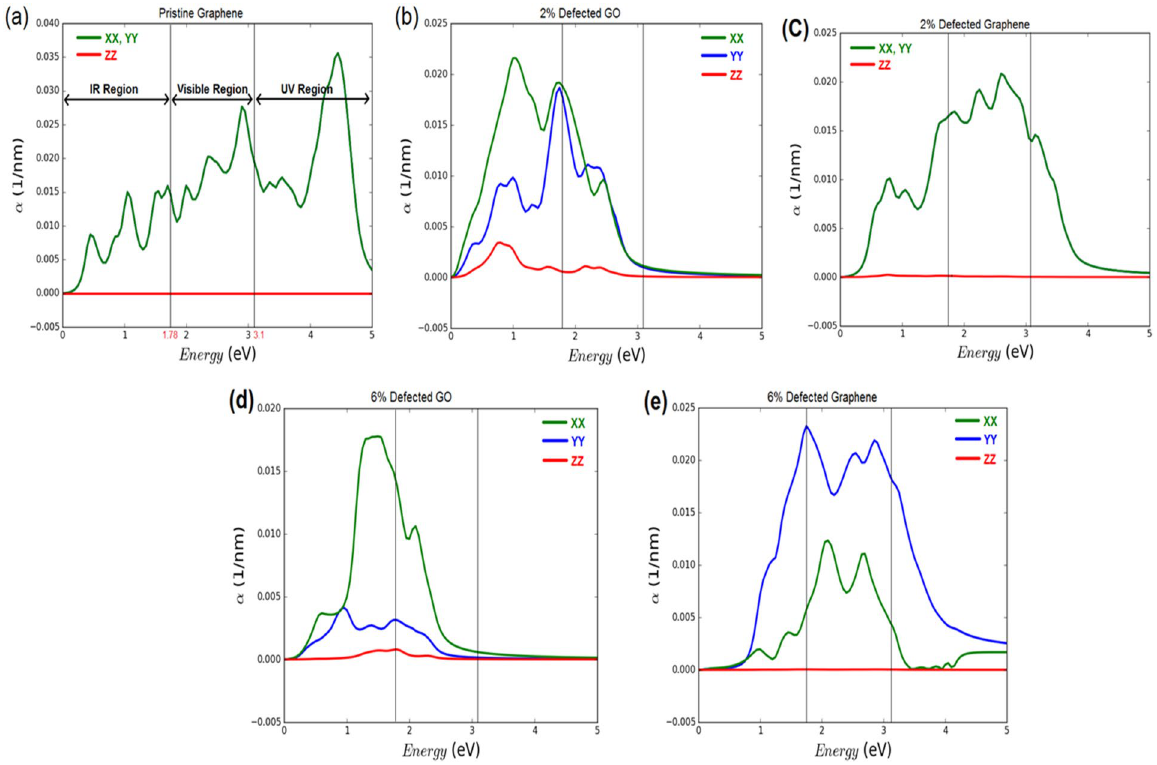
Figure 7. Optical absorption spectra for ( a ) pristine graphene, ( b ) 2% defected GO, ( c ) 2% defected GNs, ( d ) 6% defected GO, and ( e ) 6% defected GNs.